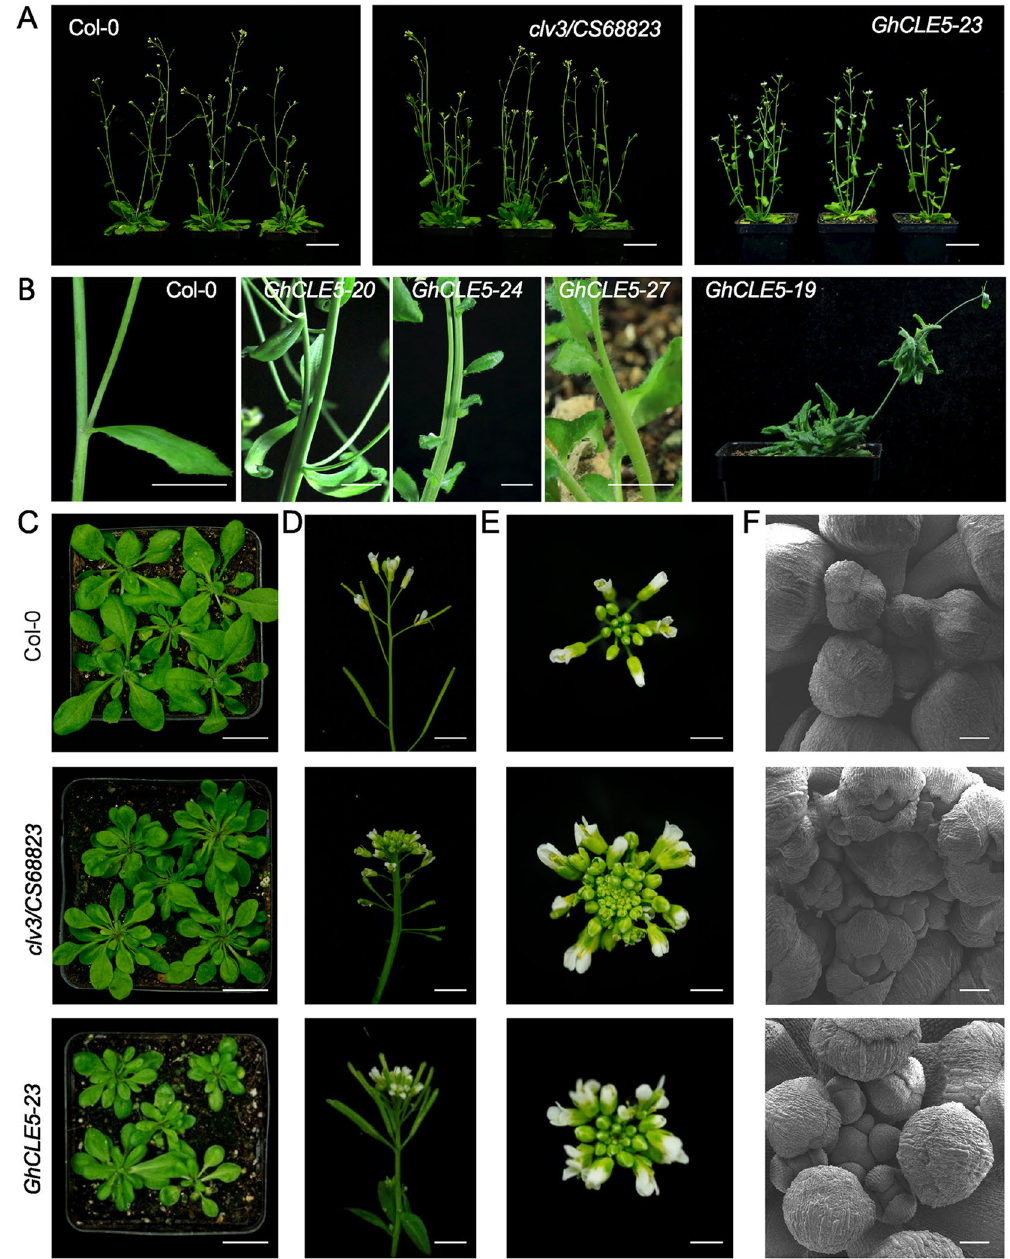
Figure 3. The phenotype of Arabidopsis thaliana with ectopic expression of GhCLE5 . ( A ) The 6-week-old plant. ( B ) The stems of the GhCLE5 transgenic Arabidopsis plants from multiple T1 lines. ( C ) The photo images of 4-week-old plants. Bar = 2 cm. ( D ) The vertical view of florescence. Bar = 5 mm. ( E ) The bird’s-eye view of the florescence. Bar = 1 mm. F: The scanning electron microscope (SEM) images of the shoot apical meristem (SAM). Bar = 100